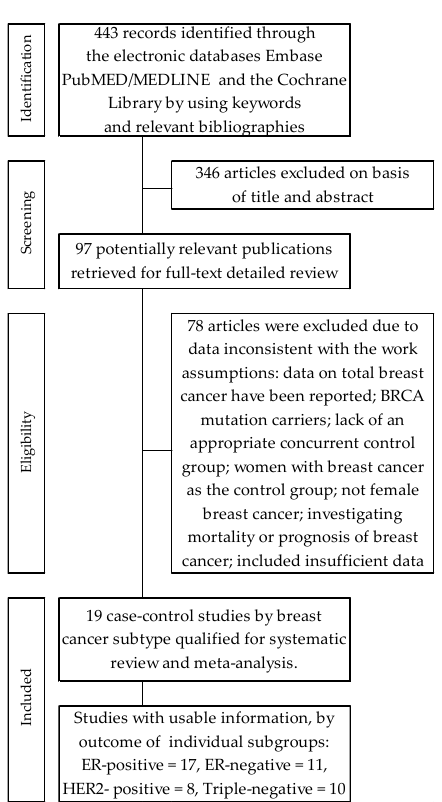
Figure 1. Flowchart of the selection procedure for studies included in the current review and meta- analysis.